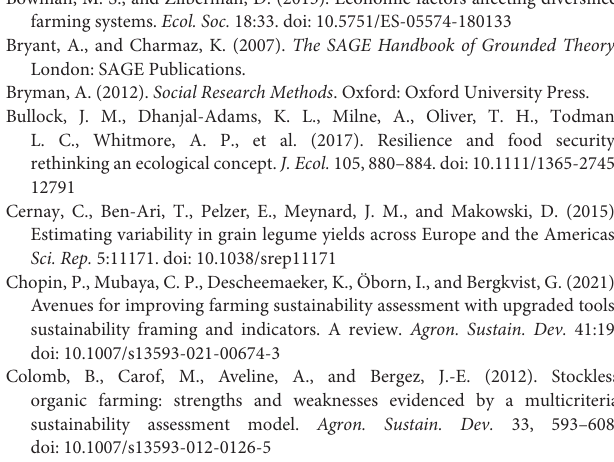
Supplementary Table 1 | Indicators from the sustainability assessment framework that were excluded or set to zero. Supplementary Table 2 | MCDA tree including the indicators at the different hierarchical levels. Supplementary Table 3 | Values obtained from the sustainability assessment framework for all the crop rotations included in the